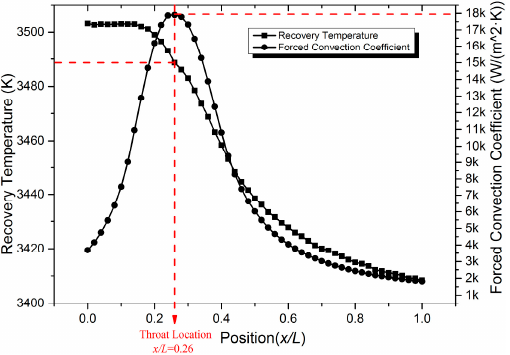
Figure 5. Forced convection coefficient and recovery temperature along the wall.